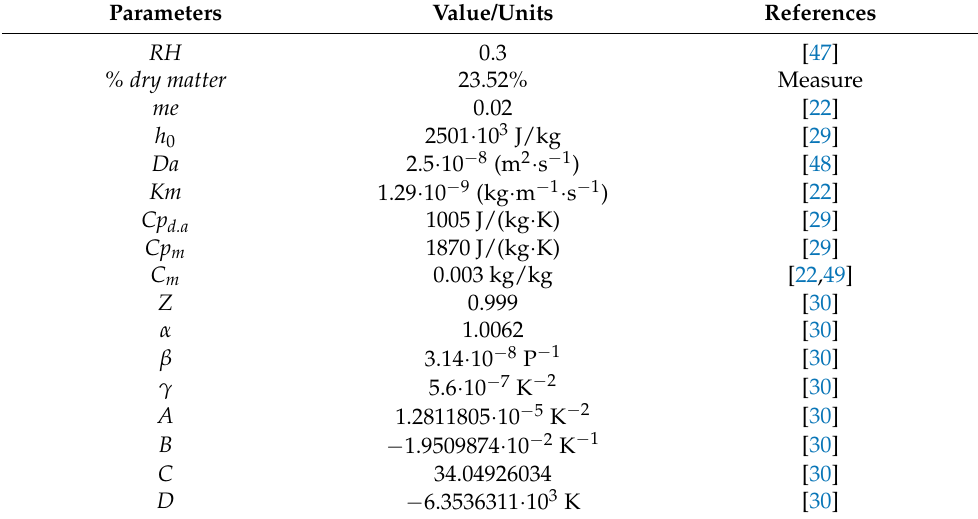
Table 5. Equations used to calculate the numerical parameters for the Lewis analogy.